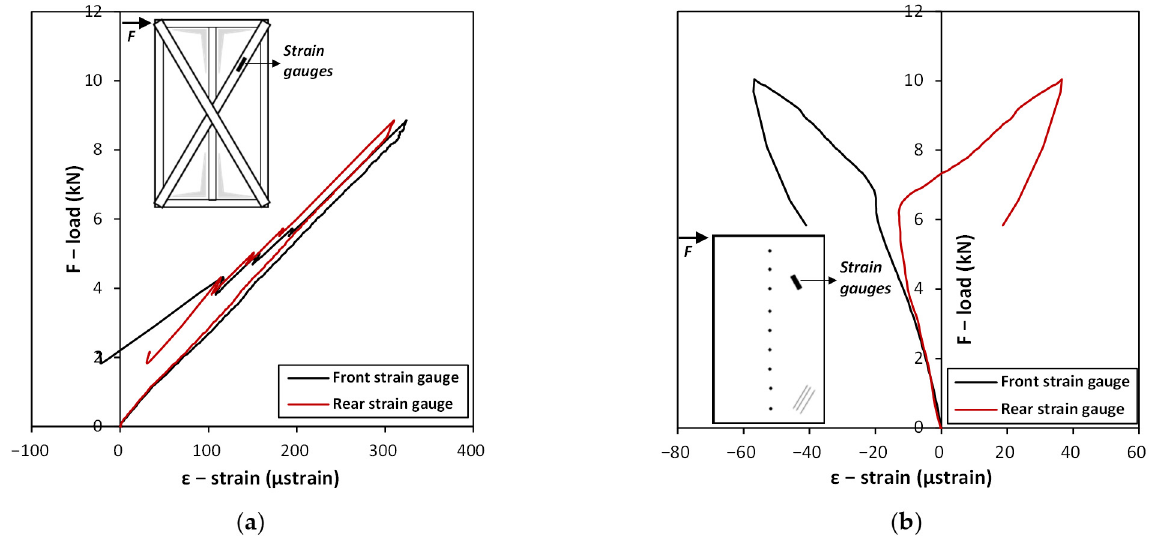
Figure 5. Strain gauges measurements in walls ( a ) XB1.5_150_M and ( b ) SS1.5_150_M.